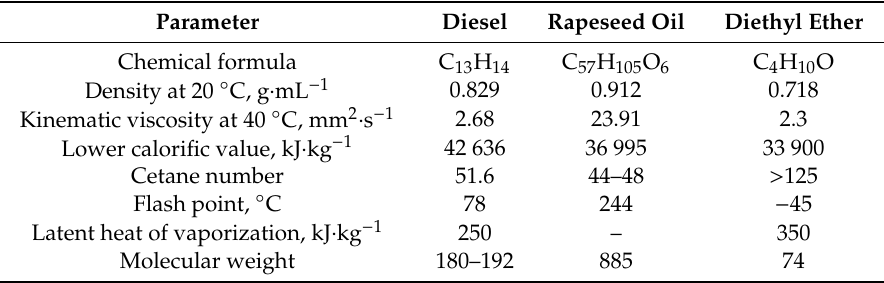
Table 1. Basic parameters of diesel fuel, rapeseed oil and diethyl ether